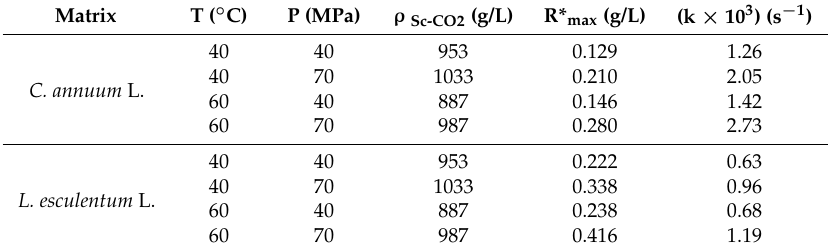
Table 3. Values calculated for the kinetic constant (k) by Chrastil’s equation and related to carotenoid extraction from pepper and tomato peels as a function of pressure of Sc-CO 2 (P = 40; 70 MPa) and temperature (T = 40; 60 ◦